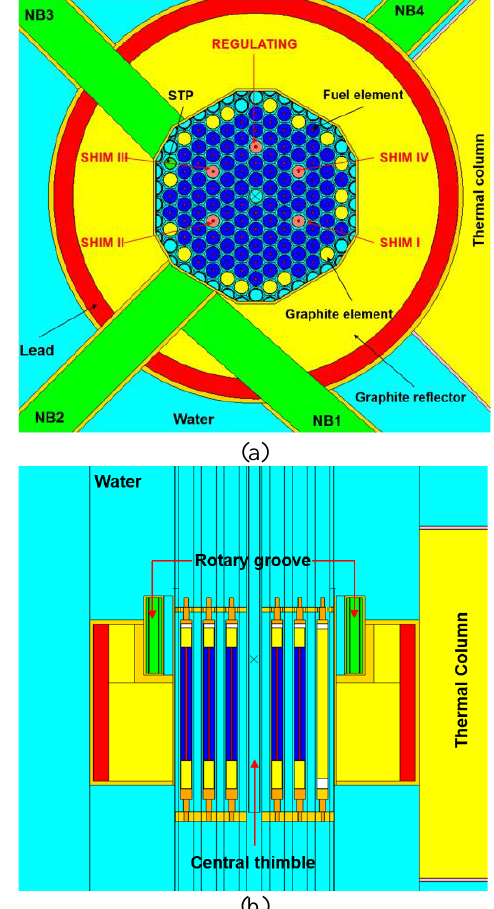
Fig. 2. (a) Side and (b) top view of the TRIGA reactor core as described in the TRIPOLI-4